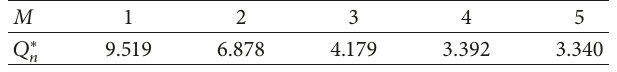
Table 1: Modified R / S statistics for each index. Table 2: Modified R / S statistics of SMPI.